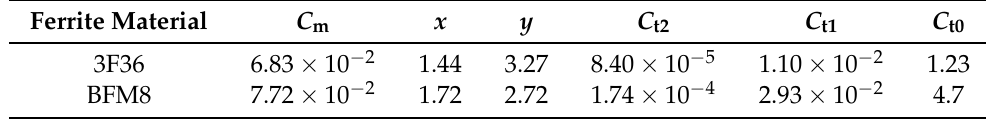
Table 3. Steinmetz coefficients of the used ferrite materials